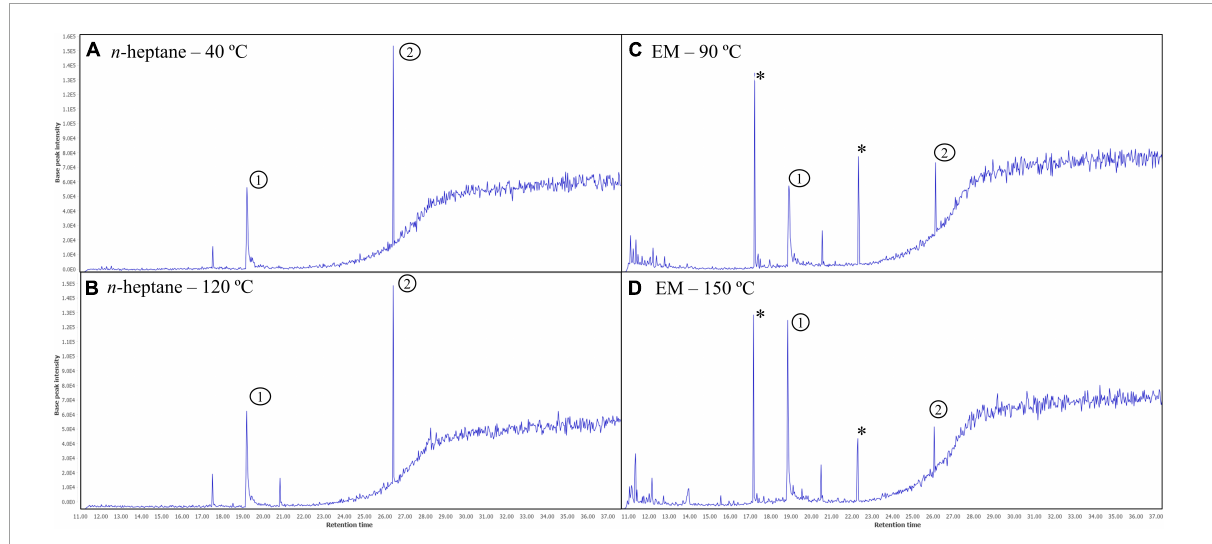
FIGURE3 GC-QToF-MS chromatograms of the lower and higher temperature of soybean n -heptane extracts at 40 (A) and 120 ◦ C (B) and eucalyptol/menthol (1:1) – EM at 90 (C) and 150 ◦ C (D) performed by PLE. The peaks marked with * were related to phthalate contaminants identified in NaHDES candidate